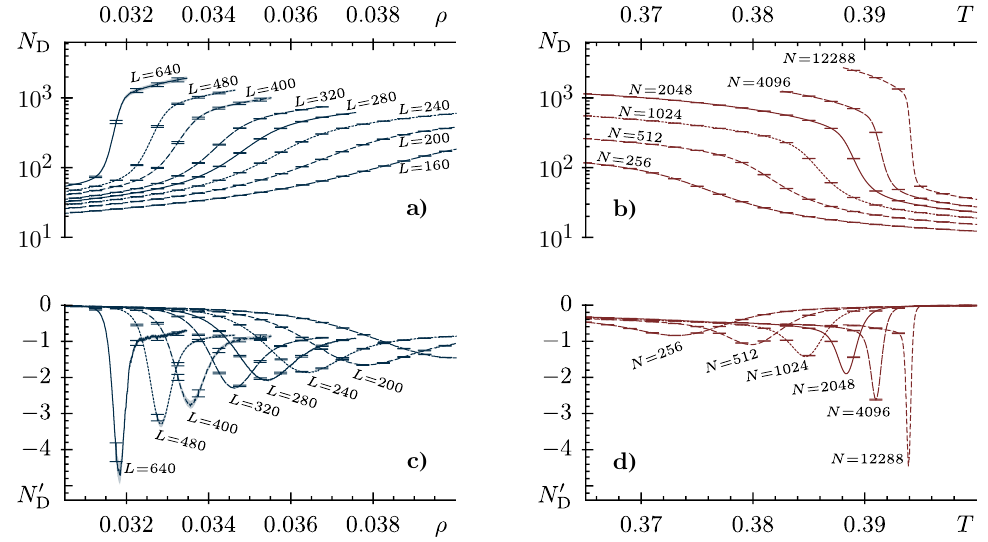
Figure 6: Scaling behaviour of the droplet formation-dissolution transition at fixed temperature T = 0.4 (left) and fixed density ρ = 0.027857 (right): a, b) Droplet size N as function of density and temperature, respectively. As the system size is D increased, the characteristic first-order discontinuity emerges analogously in both regimes and N is of similar magnitude for comparable system sizes. c, d) As de- D scribed in the text, N (cid:48) is a proxy of the slope of N and its peak positions indicate D D the finite-size transition